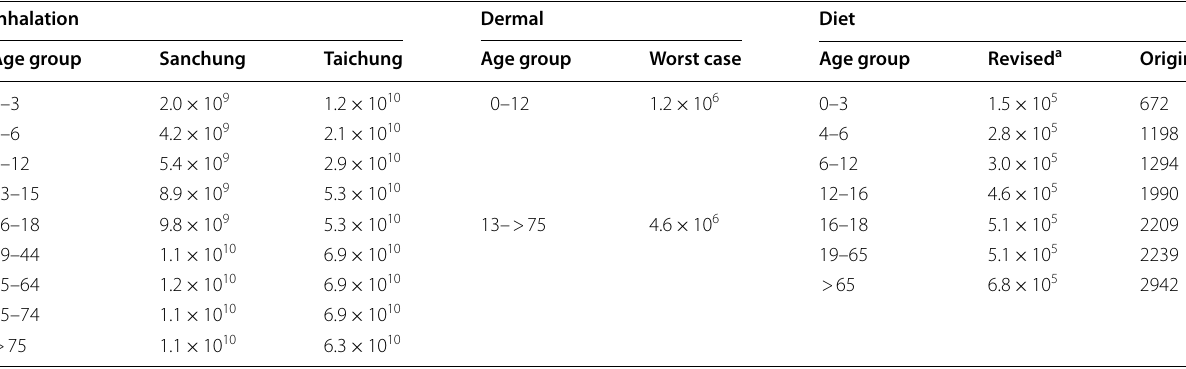
Table 4 95% Margin of exposure (MOE) estimation from the three exposure pathways in